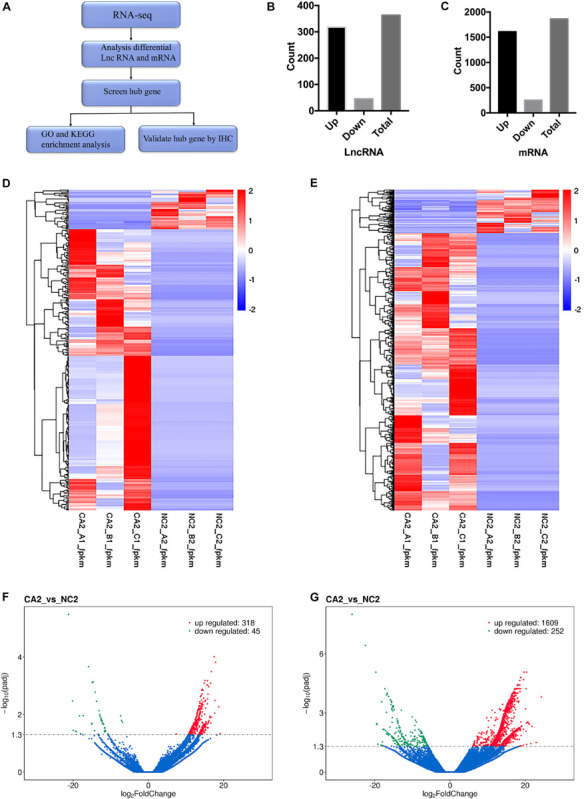
Differential lncRNA and mRNA expression between tumor and paratumor tissues of patients with PanNENs. (A) Workflow of the study. (B) Numbers of upregulated and downregulated lncRNAs. (C) Numbers of upregulated and downregulated mRNAs. (D) Heatmap of differentially expressed lncRNAs between the tumor and paratumor tissues. (E) Heatmap of differentially expressed mRNAs between the tumor and paratumor tissues. (F) Volcano plot of differentially expressed lncRNAs between the tumor and paratumor tissues. (G) Volcano plot of differentially expressed mRNAs between the tumor and paratumor tissues n = 3.